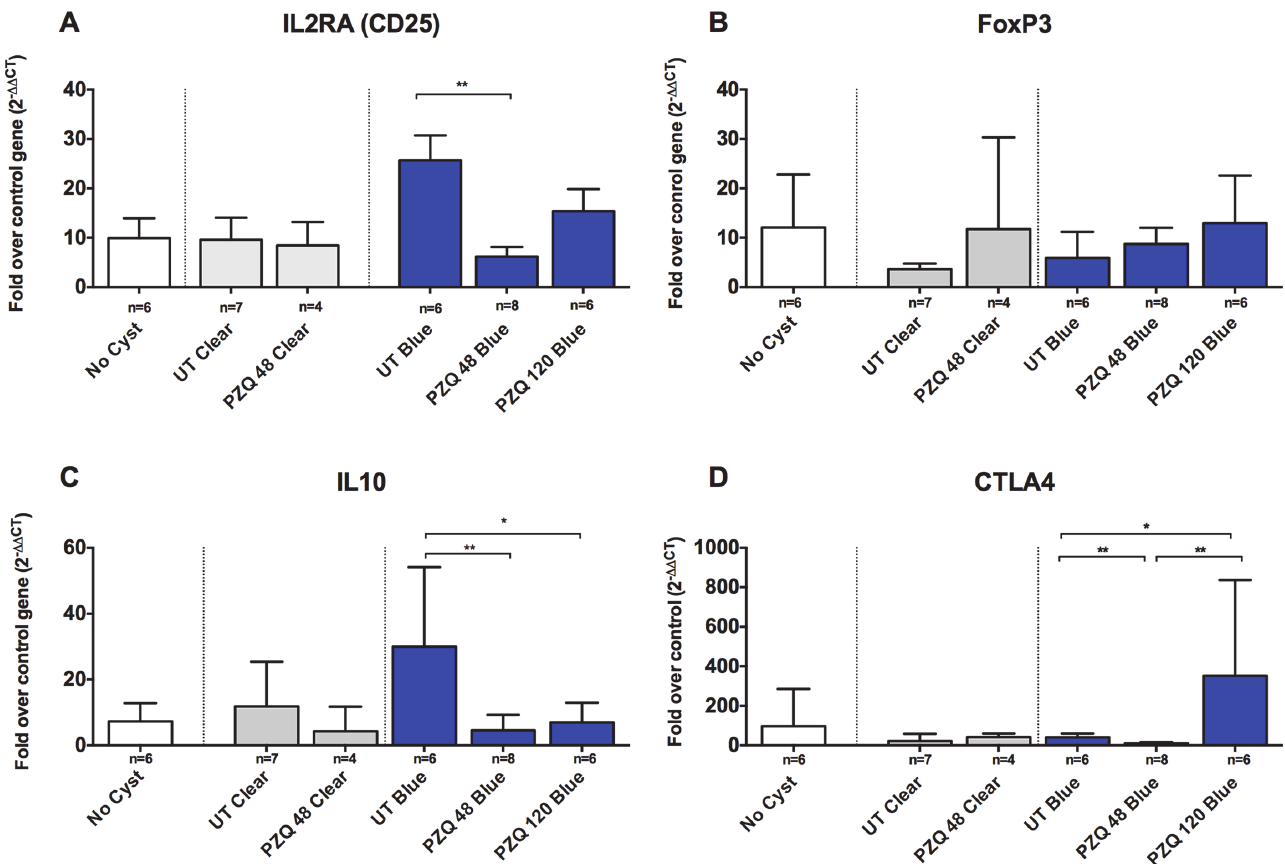
Fig 5. Increased expression of CD-25 and IL-10 in EB capsules following PZQ treatment. Expression levels of RNA in brain tissue samples from EB- stained and clear capsules were quantified (See Methods). Shown are expression levels, depicted as fold increase over the RNA levels for the reference (housekeeping) gene (18S rRNA), encoding four representative regulatory T cells (Treg) phenotyping and functional markers: CD25 (A; number [n] of samples for the indicated types of capsules are shown below each bar), FoxP3 (B), IL-10 (C) and CTLA4 (D). Statistically significant differences in levels of gene expression are indicated by asterisks (p < 0.05, Mann-Whitney U test). Asterisks represent level of significance: * : p < 0.05; ** : p < 0.01; *** : p < 0.005.